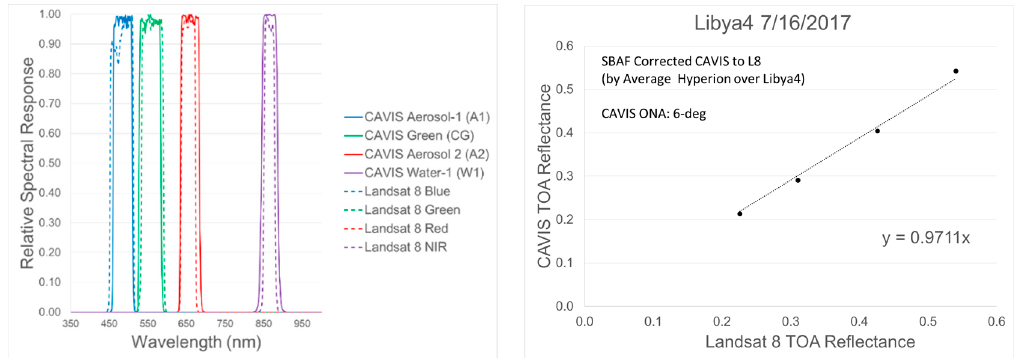
Figure 8. The left panel illustrates cross-calibration of Digital Globe’s CAVIS instrument to Landsat 8 using the Libya 4 PICS. Excellent agreement is obtained due in large part to the similarity of the spectral bandpasses between the two instruments as illustrated in the right panel.